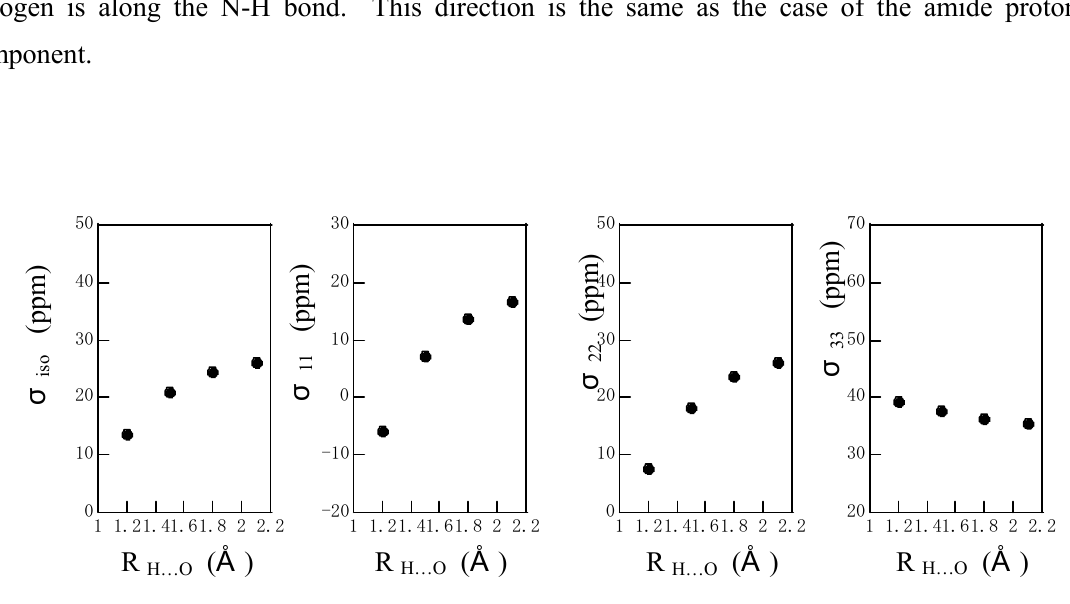
, σ and σ of the amide proton of an N-methylacetamide 11 22 33 , where the hydrogen-bond angle is fixed N…O